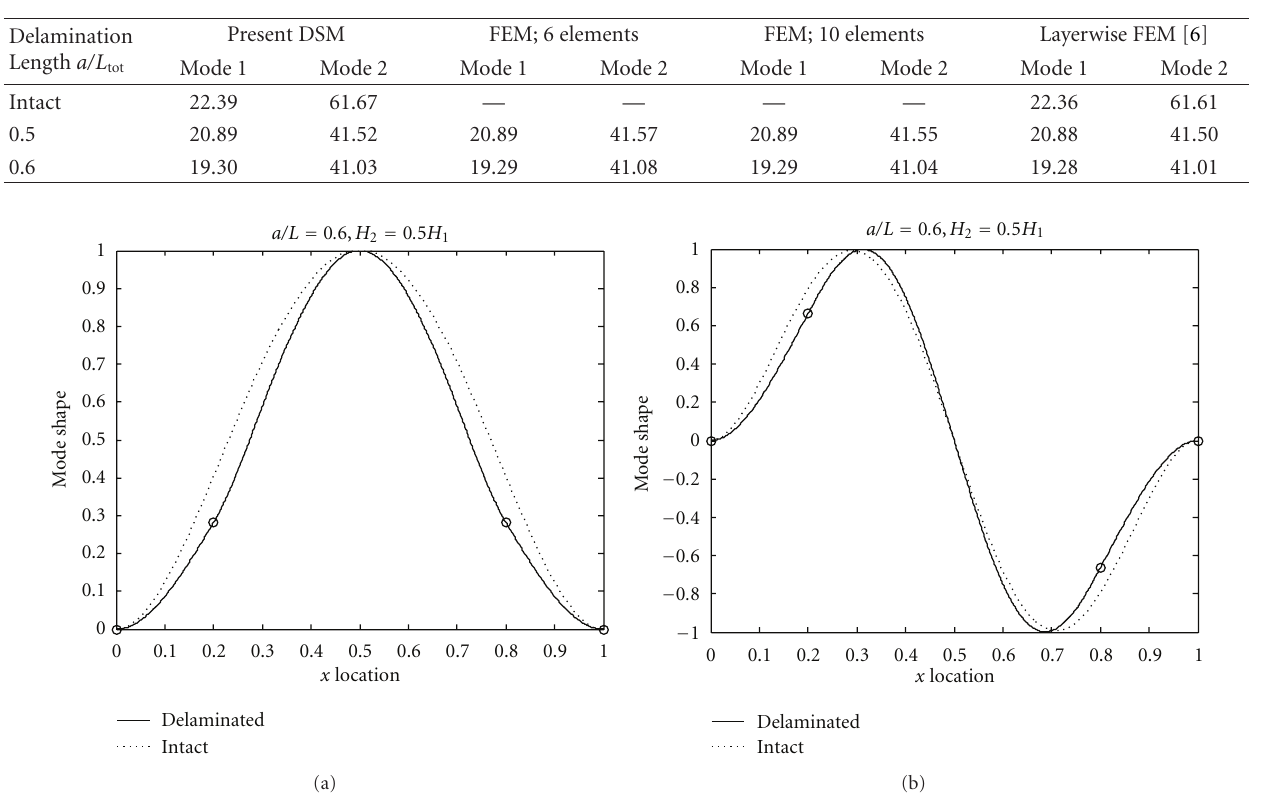
Table 2: Natural frequencies λ 2 of the split beam; DSM, FD-FEM, and standard FEM models.